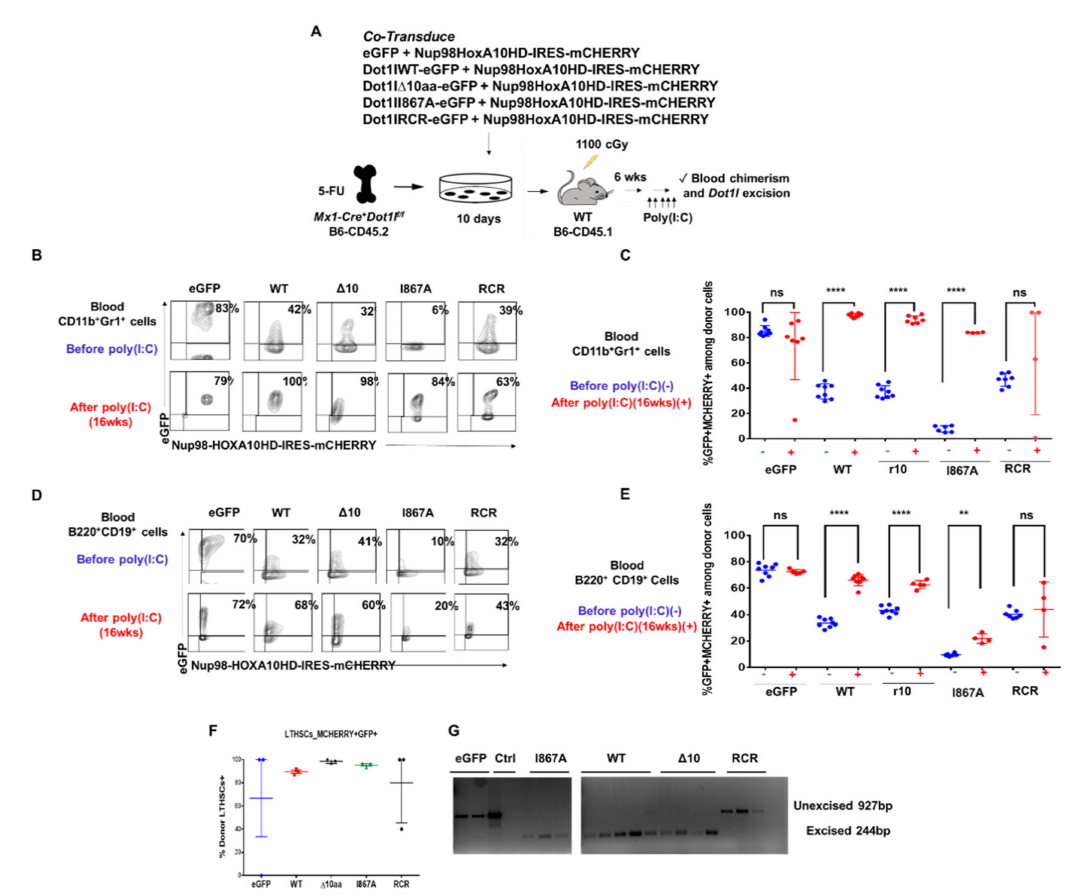
Figure 5. DOT1L’s enzymatic activity is essential in hematopoiesis, but its AF9-binding domain is dispensable. ( A ) Experimental approach. BM harvested from 5-FU-treated Mx-Cre + Dot1l f/f B6-CD45.2 donors was co-transduced ex vivo with MSCV-based constructs expressing NUP98-HOXA10HD IRES-mCherry and eGFP alone vs. eGFP + DOT1L-WT, DOT1L-D10, DOT1L I867A or DOT1L-RCR. After ex vivo expansion, these cells were transplanted into irradiated B6- CD45.1 recipients. After hematopoietic reconstitution, poly(I:C) was administered to inactivate endogenous Dot1l , followed by analysis of chimerism and Dot1l excision; ( B ) Representative examples of flow cytometric data. Numbers show the percentage of mCherry + eGFP + cells among blood myeloid cells; ( C ) Flow cytometric analysis of blood CD45.2 + donor- derived CD11b + Gr1 + myeloid cells for mCherry and eGFP expression, before (blue) and 16 wks after (red) poly(I:C) (5 i.p. doses). Data from individual mice are shown. Increased representation of cells expressing DOT1L-WT, DOT1L-D10, and DOT1L-I867A, but not eGFP or DOT1L-RCR was seen after poly(I:C); ( D ) Flow cytometric analysis of blood CD45.2 + donor-derived B220 + CD19 + myeloid cells for mCherry and eGFP expression, before (blue) and 16 wks after (red) poly(I:C) (5 i.p. doses). Data from individual mice are shown. Increased representation of cells expressing DOT1L-WT, DOT1L-D10, and DOT1L-I867A, but not eGFP or DOT1L-RCR was seen after poly(I:C); ( E ) LT-HSCs after poly(I:C) administration at the termination of the study. DOT1L-WT, DOT1L-D10 and DOT1L-I867A recipients have LT-HSCs that are comprised mostly of eGFP+ donor cells; ( F ) PCR analysis of Dot1l excision in sort-purified blood CD45.2 + mCherry + eGFP + myeloid cells 20 weeks after poly(I:C) administration. ( G ) DOT1L-WT, DOT1L-D10 and DOT1L-I867A recipients had ongoing myelopoiesis with fully excised Dot1l , while eGFP and DOT1L-RCR recipients had selected cells escaping Dot1l inactivation. (ns p > 0.05, ** p ≤ 0.01, **** p ≤